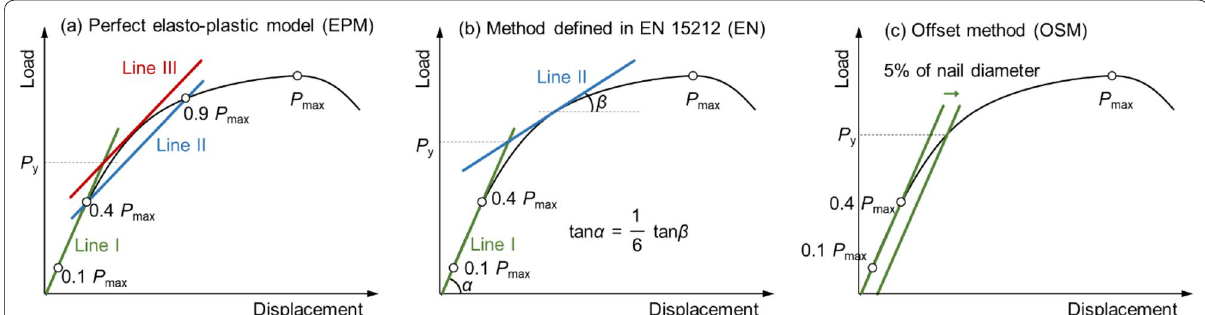
Fig. 3 Engineering techniques for determining yield loads adopted in this